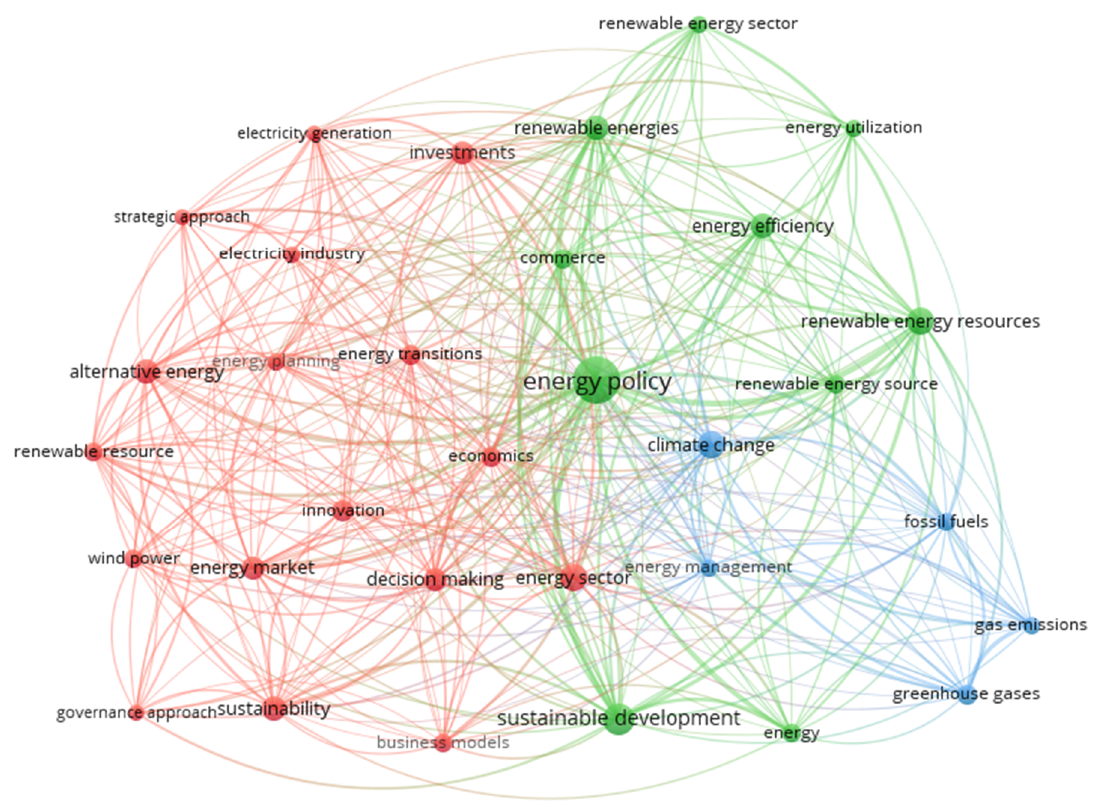
Figure 4. Bibliometric map of indexed keyword co-occurrence results from Scopus based on Query 15. Source: authors’ elaboration performed in VOSviewer (version 1.6.18).